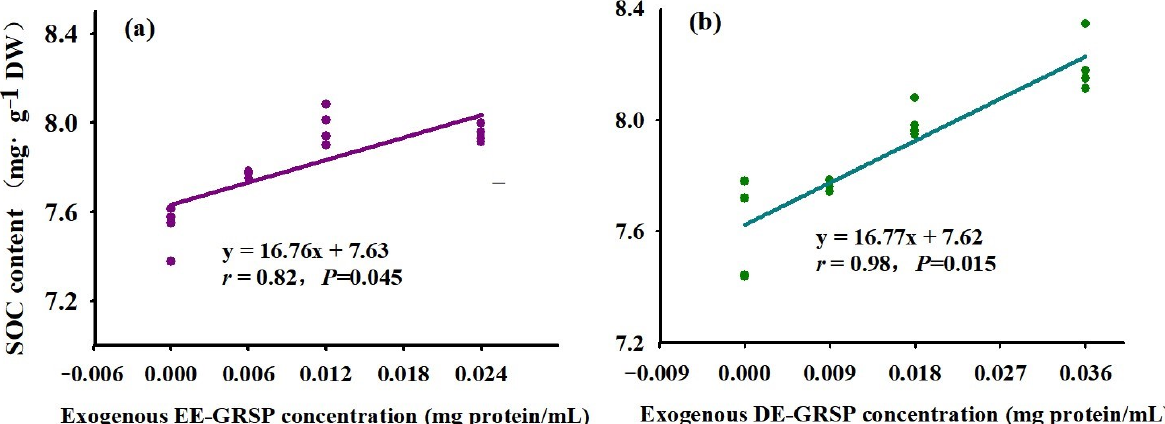
Figure 5. Effects of exogenous EE-GRSP and DE-GRSP on soil organic carbon of trifoliate orange seedlings. Data (mean ± SD, n = 4) followed by different letters above the bars indicate significant differences ( p < 0.05) between treatments.